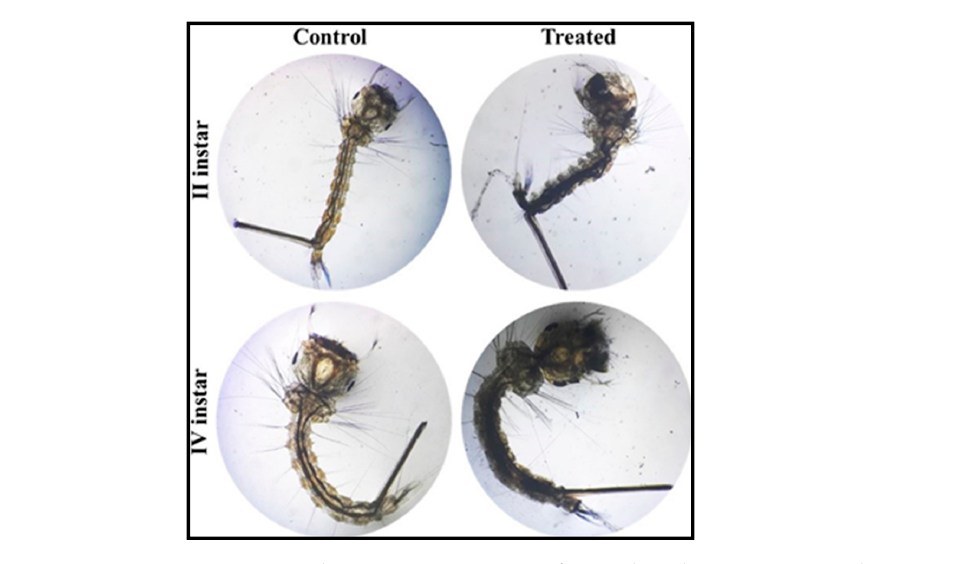
Figure 13. Light microscopic images of control- and PoAgNPs-treated mosquito larvae of C. quinquefasciatus with ×10 magnification.